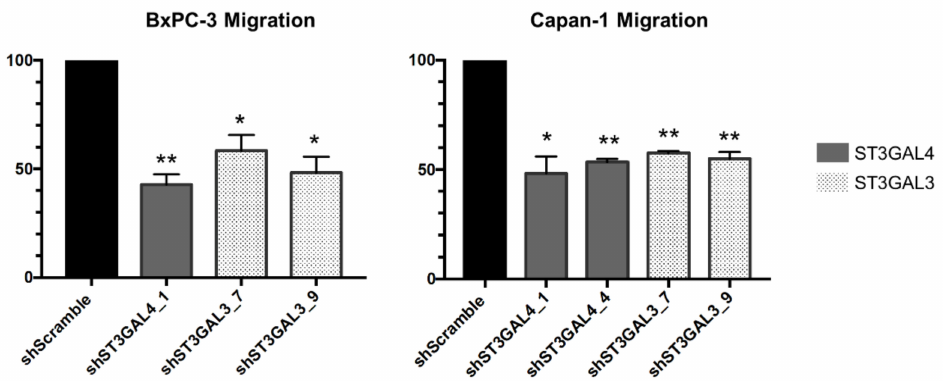
Figure 6. SLe x reduction resulted in impaired cell migration. Relative quantification of cell migration over shScramble cells of BxPC-3 knockdown cells (shST3GAL4_1, shST3GAL3_7 and shST3GAL3_9) (left) and Capan-1 cells (shST3GAL4_1, shST3GAL4_4, shST3GAL3_7 and shST3GAL3_9) (right). Cells were allowed to migrate through 8 µ m-pores-type 1-collagen coated Boyden chambers. Migrated cells were fixed and counted. Results are presented as mean ± SEM of three independent experiments. ANOVA and Tukey’s multiple comparison post-hoc test was performed. * p < 0.05, ** p <